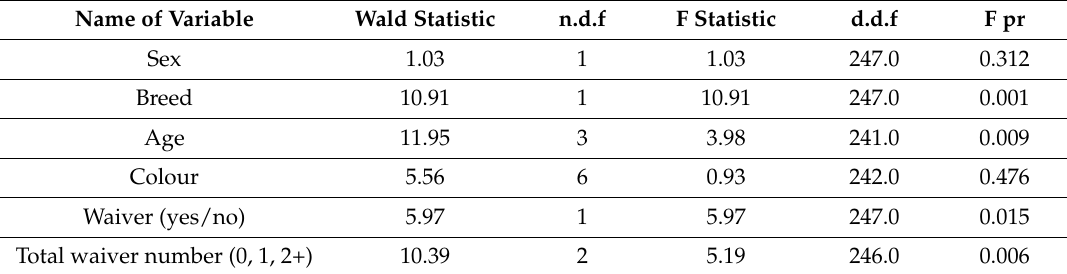
Table 5. REML multivariate model output assessing interactions between predictor values and LOS (final model).